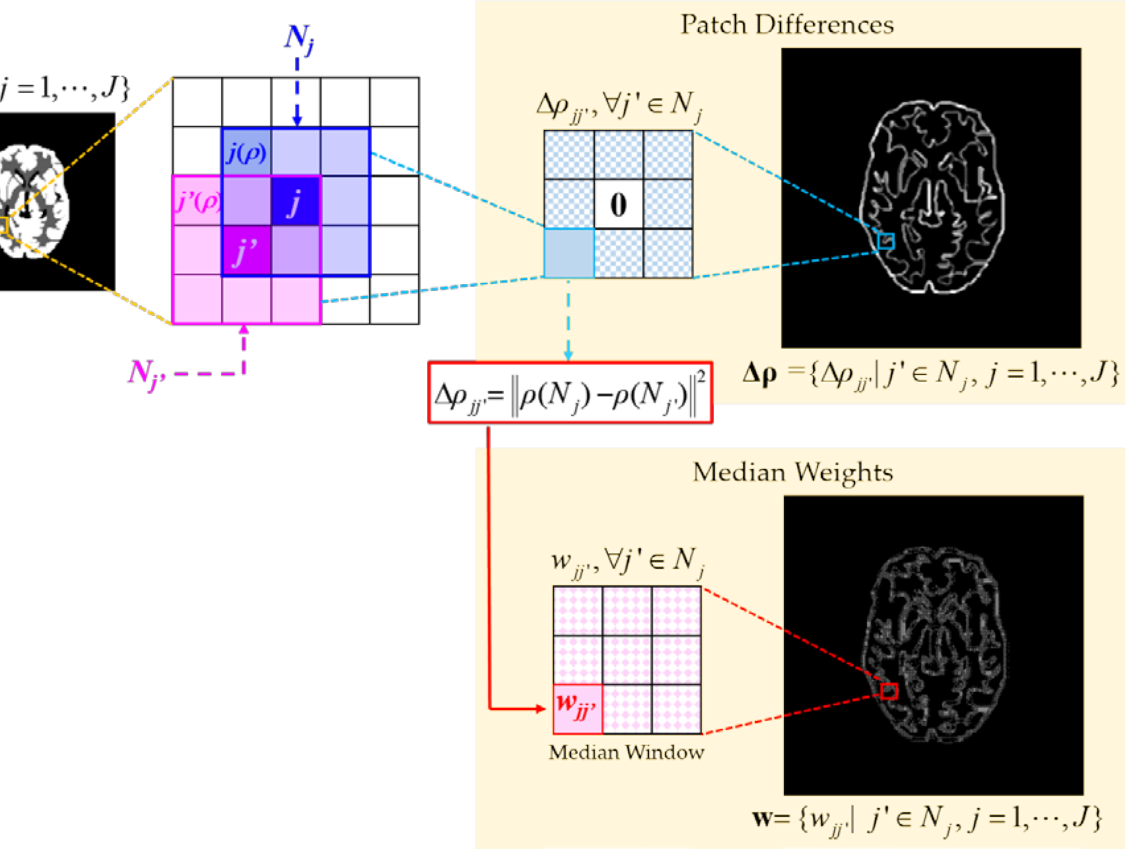
Figure 1. Illustration of similarity-driven median weights. Given the PET image f , the median weights w are determined by the patch similarities ∆ ρ